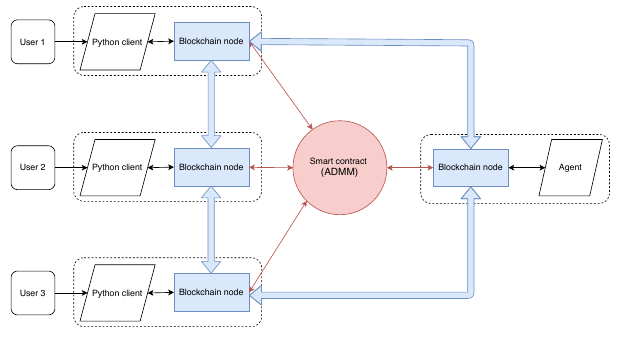
Figure 2. Blockchain framework